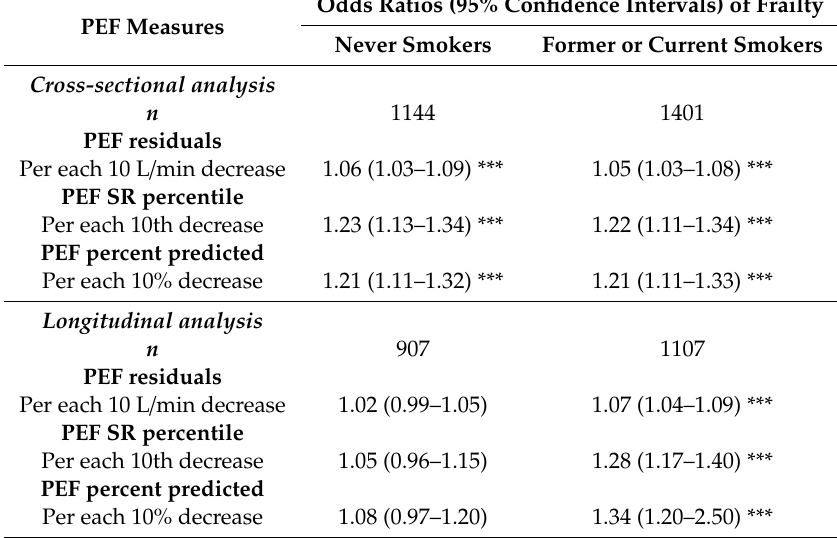
Table 5. Association between peak expiratory flow and frailty in participants stratified by smoking